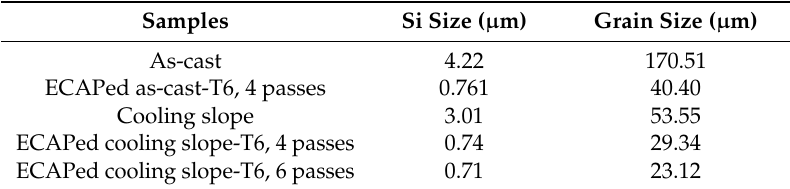
Table 1. Average size of grain size and Si particles before and after ECAP.